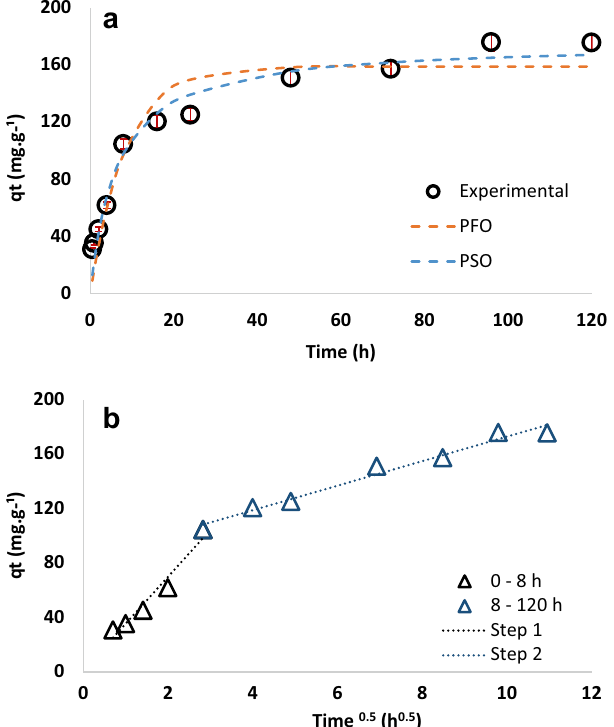
Figure 8. Comparison of experimental kinetic data with ( a ) pseudo-first-order (PFO) and pseudo-second- order (PSO) kinetics models, and ( b ) an intraparticle diffusion model. (Contact time: 0.5–120 h, initial pH: 6.5; initial Cr(VI) concentration: 100 mg L −1 ; adsorbent dosage: 0.5 g L −1 ; and temperature: 25 °C).